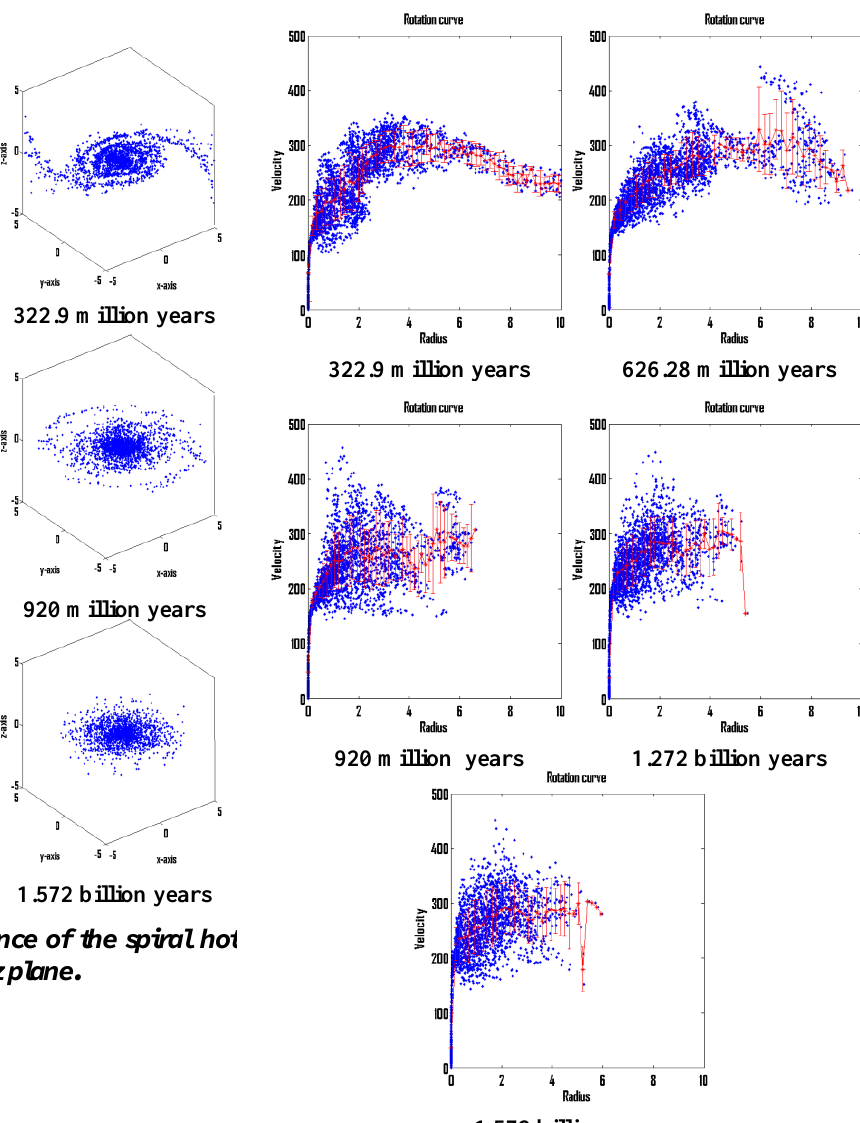
Fig.5 to 8 display the output simulation results of this case.